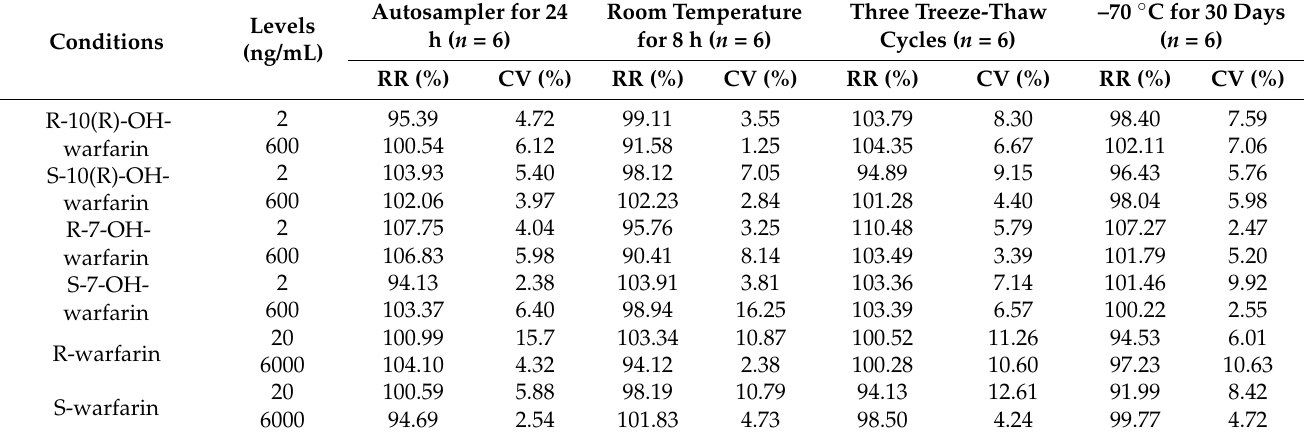
Table 4. Stability results of warfarin and hydroxywarfarins enantiomers in rat plasma under different